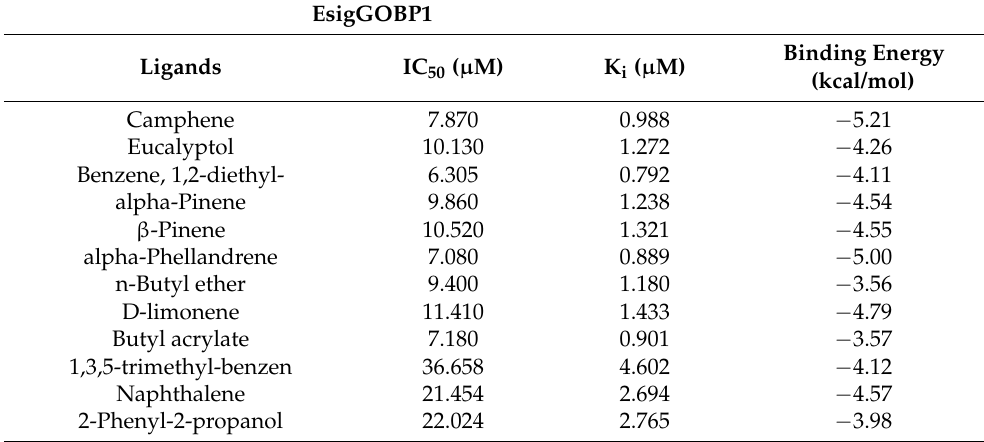
Table 1. Binding of different compounds to recombinant GOBP1 of E. signifer